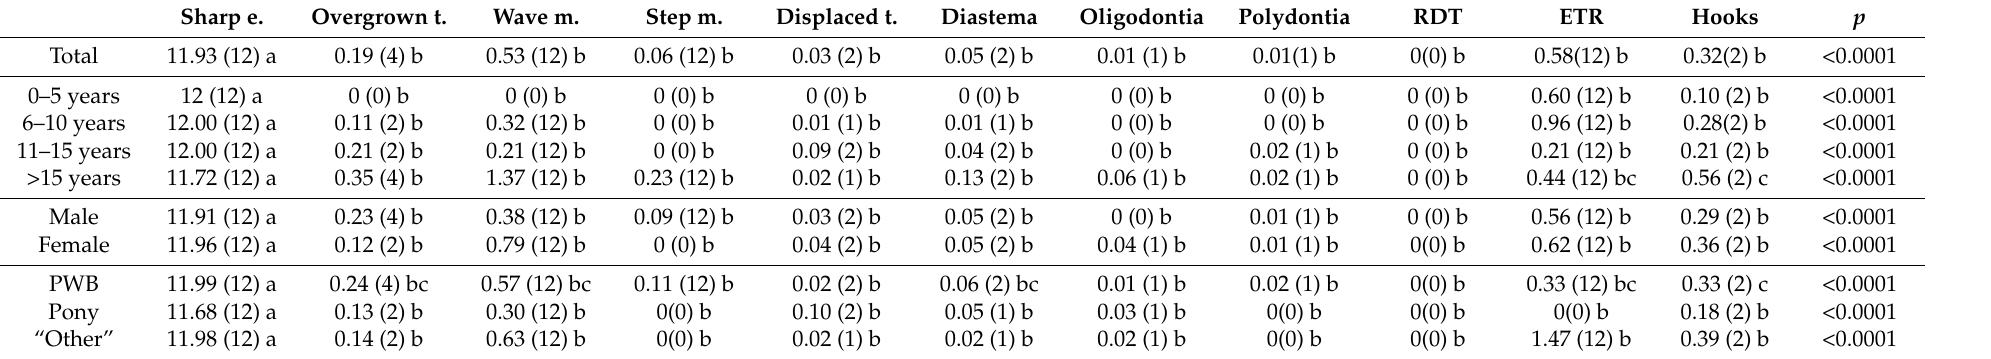
Table 9. The frequency distribution of malocclusions of molar teeth in the total 7912 examined teeth of 206 horses. Sharp e. Overgrown t. Wave m. Step m. Displaced